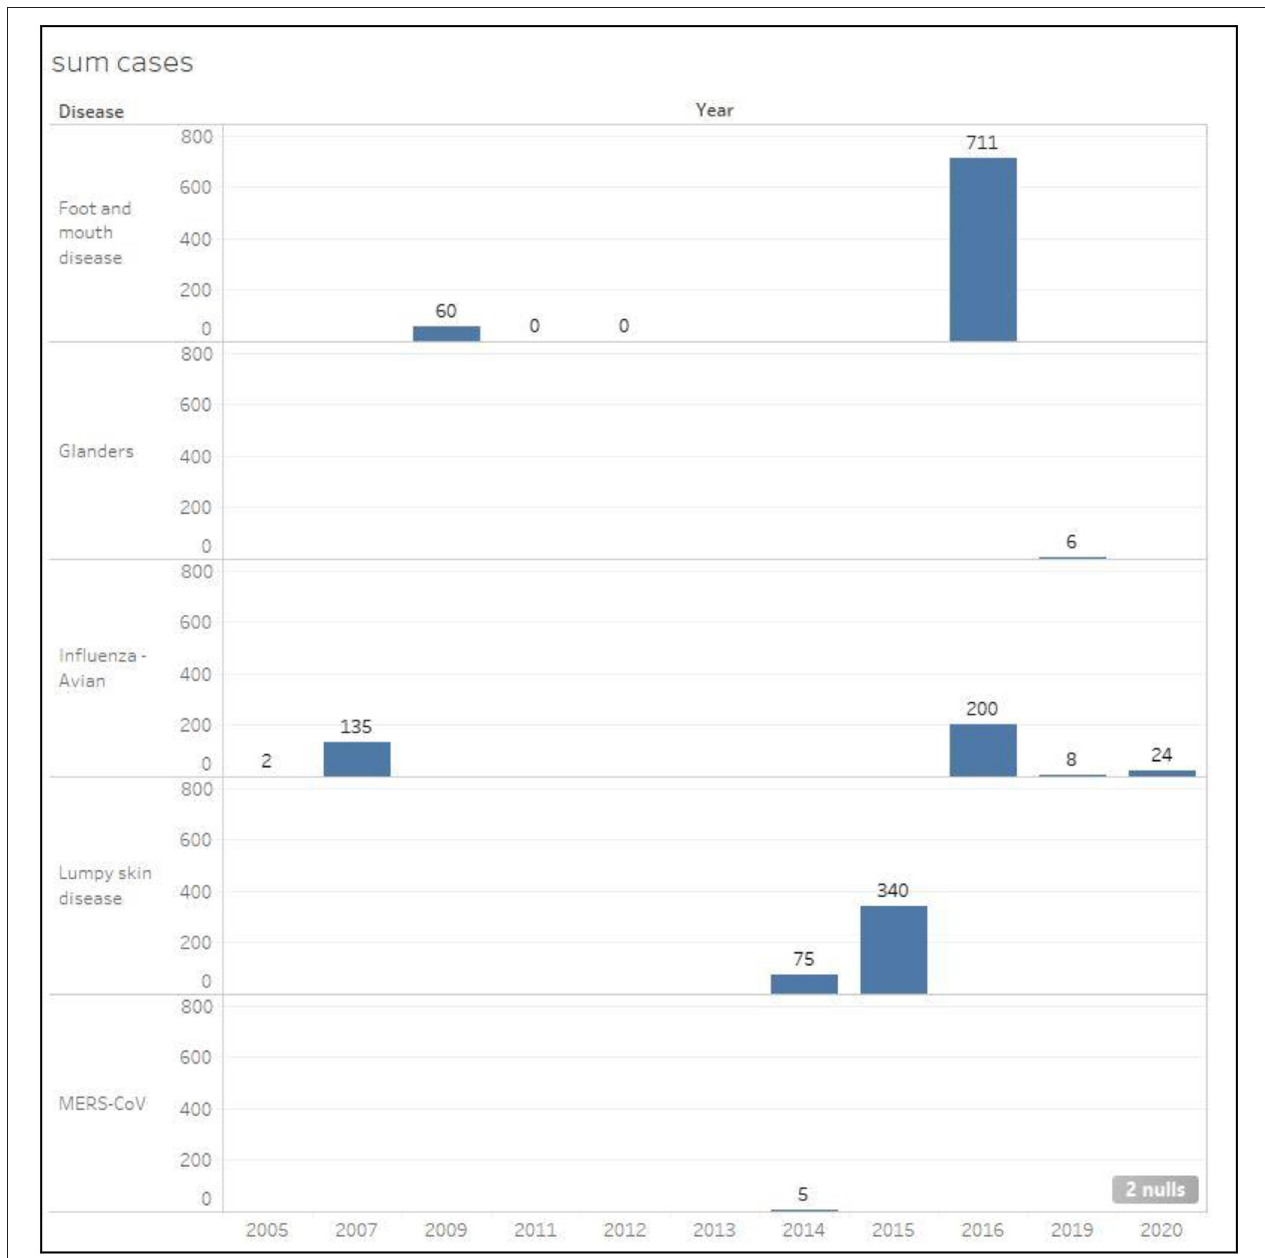
FIGURE 6 | Total number of infected cases classified by disease in Kuwait during the period